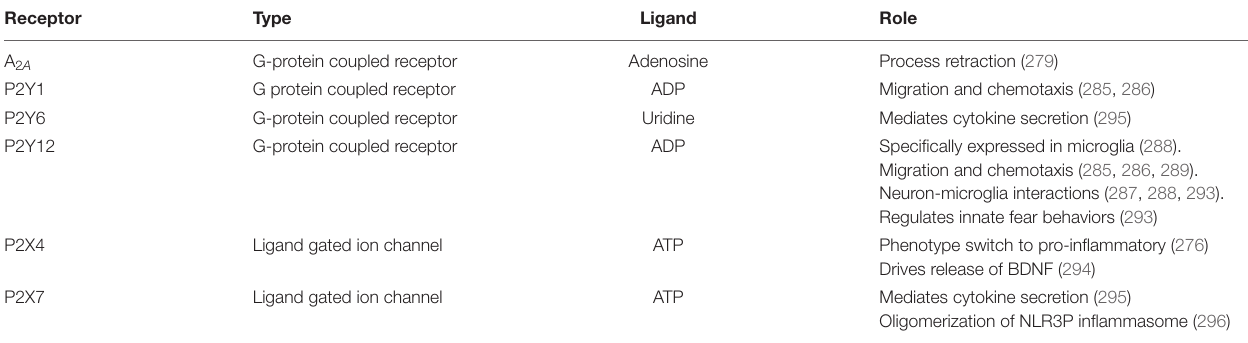
TABLE 4 | Summary of microglial purinergic signal